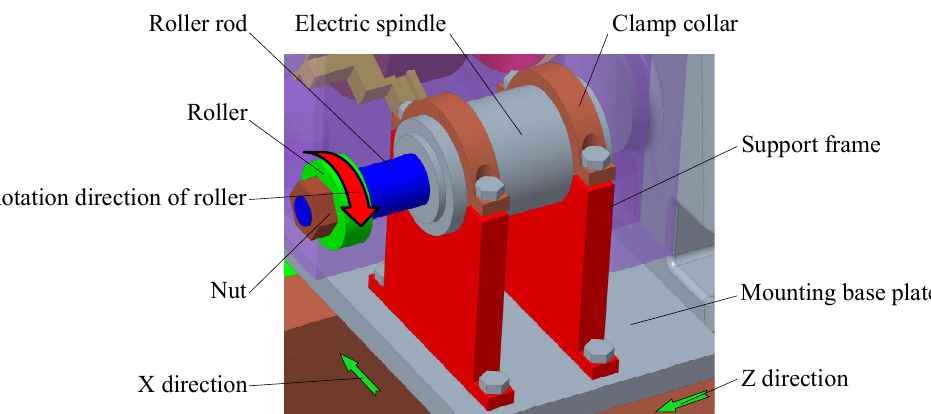
Figure 7. Schematic diagram of the roller truing device of the conductive grinding wheel.